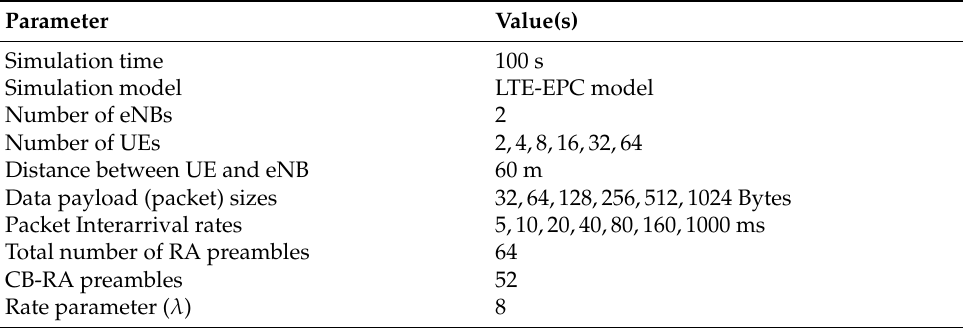
Table 1. Simulation parameters and their